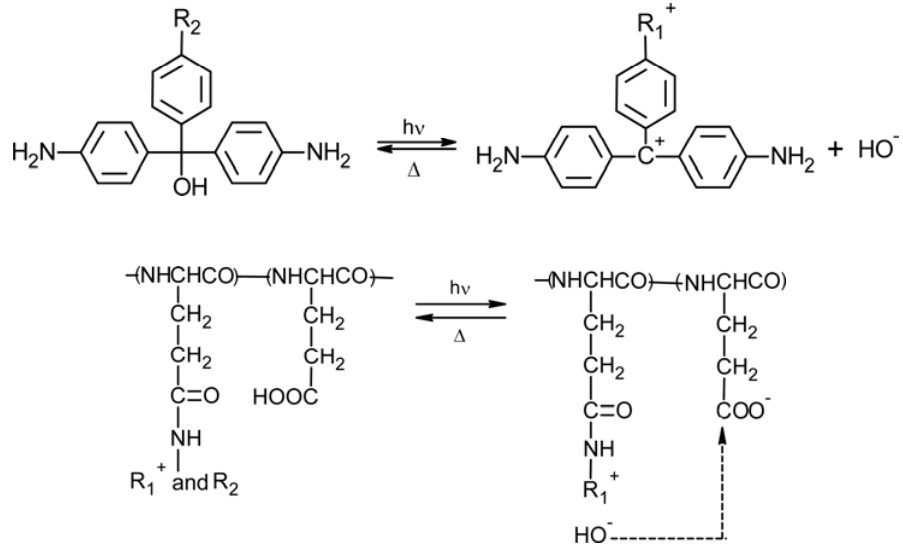
Figure 6. Photo-dissociation of pararosaniline groups and acid dissociation of L -glutamic acid